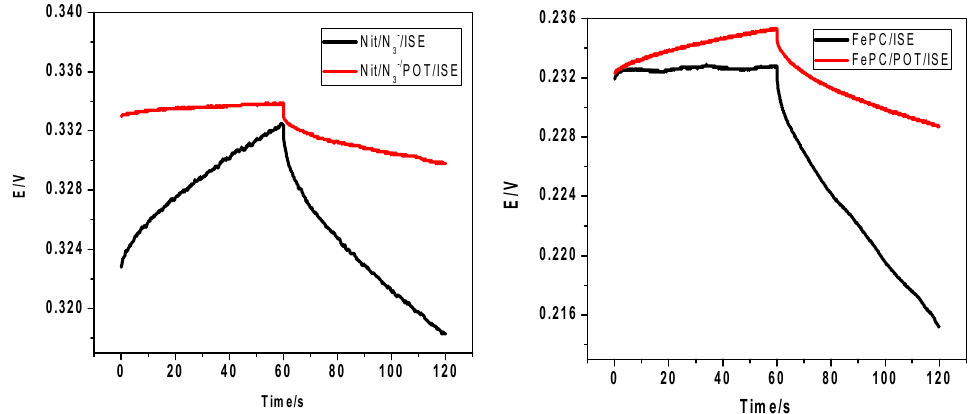
Figure 4. Measurements for azide membrane sensors with and without POT as a solid contact Figure 4. measurements for azide membrane sensors with and without POT as a solid contact material.